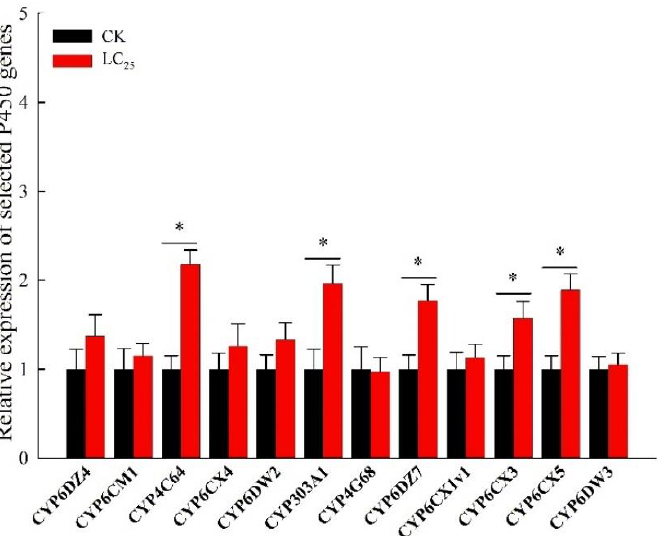
Figure 4. Expression profiles of 12 candidate P450 genes of the F 0 generation of B. tabaci adults in the CK and LC 25 treatment groups. Values are presented as means ± SE. Asterisks above error bars indicate significant differences ( p <